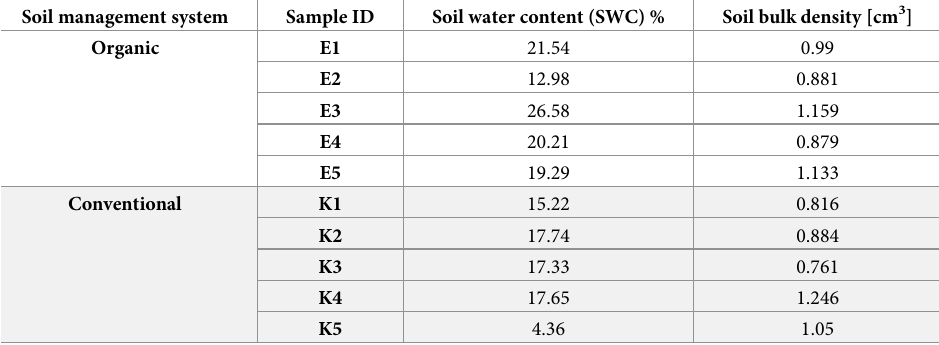
Table 2. Average soil water content and bulk density in the tested soil